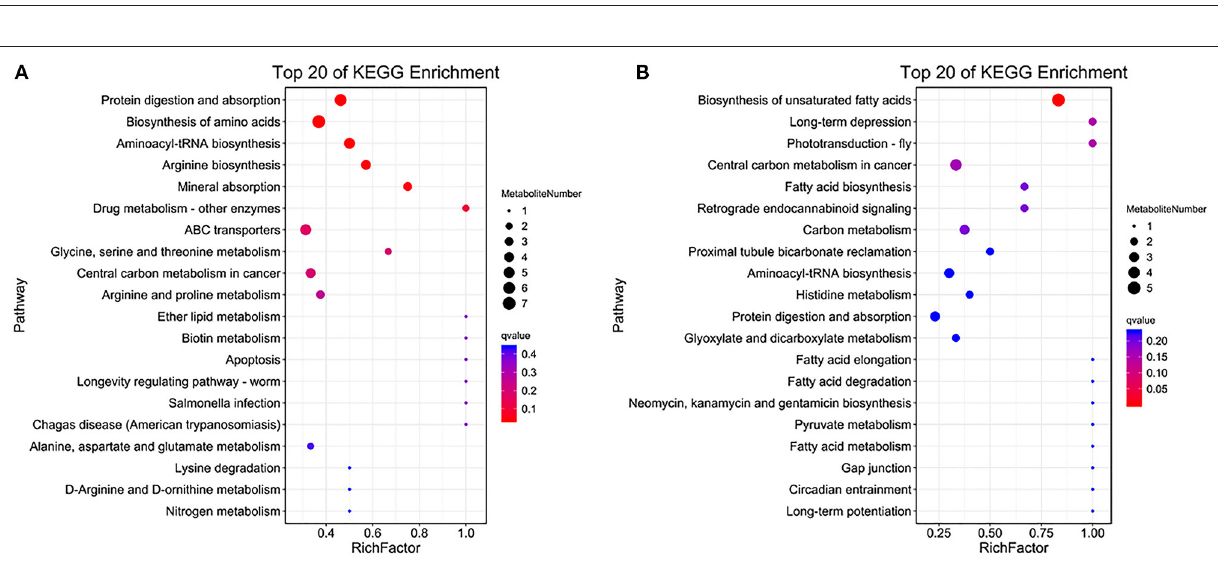
FIGURE 7 | Comparative metabolomics analysis of changes in the intestine metabolites in the starvation and control groups. (A) Variation of intestinal metabolite structure represented by PCA of multivariate statistical analysis (MVA). (B) Venn diagram showing the metabolite profile between starvation and control groups in positive ion mode (PIM) and (C) negative ion mode (NIM). (D) Kruskal–wallis test was used to screen the different metabolites in the three groups (The names of the annotated bacteria displayed the top 63). (E) The correlation among 30 genera and 30 metabolites is shown using a heatmap. Color intensity represents the magnitude of the correlation. Red, positive correlations; blue, negative correlations.